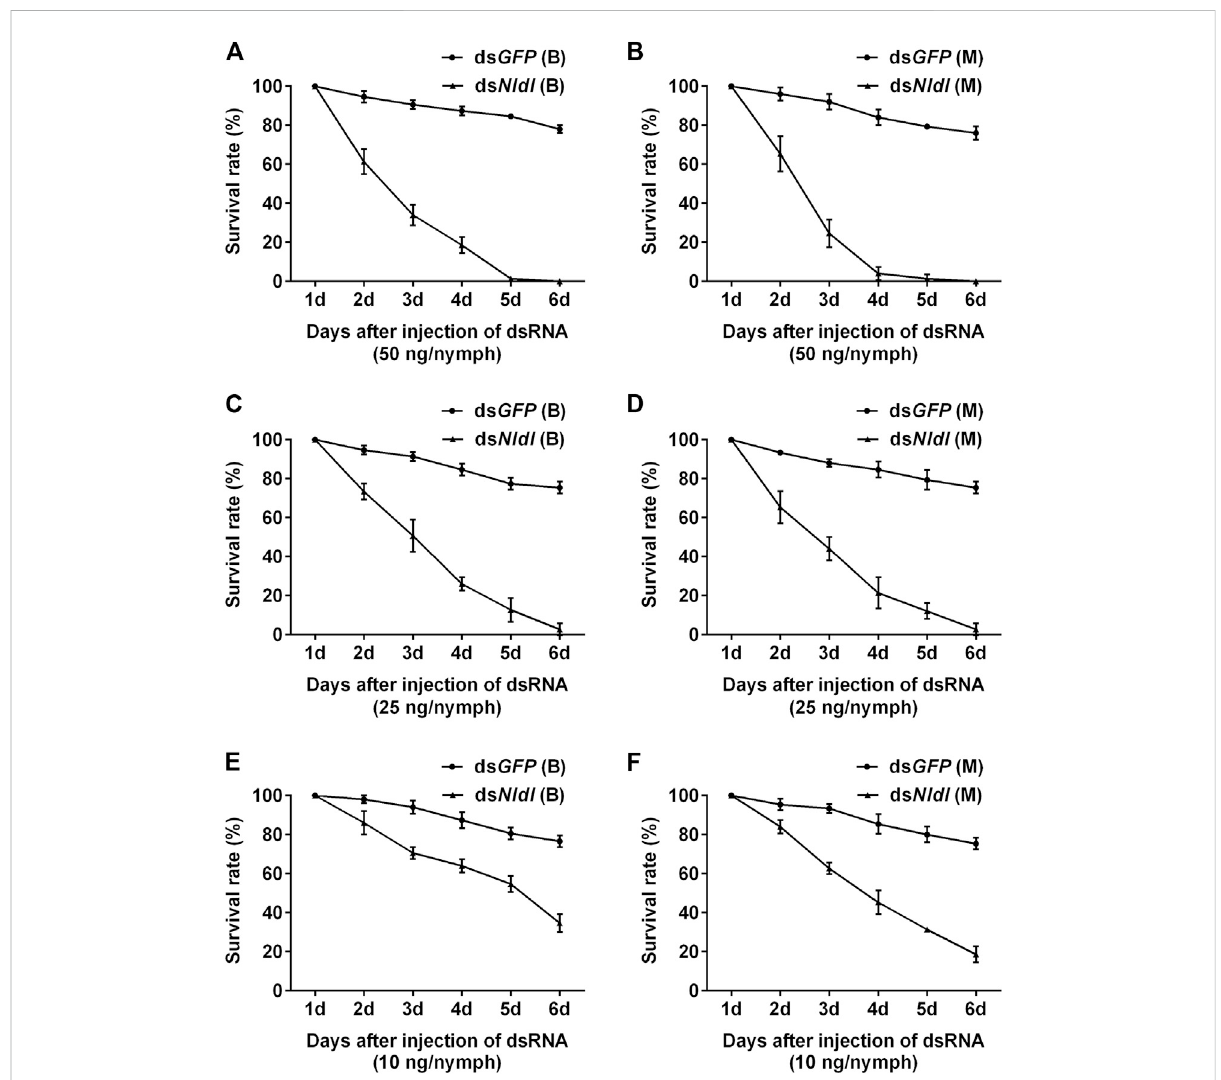
FIGURE 6 Survival rates of BPH developed from nymphs treated with ds Nldelta . (A,B) : Survival rate of 50 ng ds Nldelta injection of the Brachypterous (A) and Macropterous strain (B) . (C,D) : Survival rate of 25 ng ds Nldelta injection of the Brachypterous (C) and Macropterous strain (D) . (E,F) : Survival rate of 10 ng ds Nldelta injection of the Brachypterous (E) and Macropterous strain (F) . The nymphs injected with dsRNA were third-instar nymphs on the second day after ecdysis. The test nymphs began transforming to adults on the sixth day, and all surviving nymphs developed into adults on the seventh day. Wetherefore recordednymph survival rates onthesixth dayafter treatment and additionally recordedtheemergence rates. Equivalent ds GFP wasusedasacontrol.Eachvalueisameanofthreereplicates,with50nymphsperreplicate.Datarepresentthemean±standarderror( n